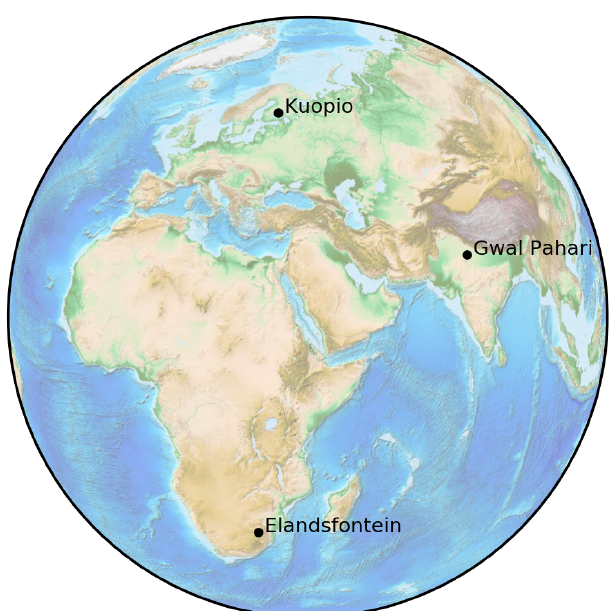
Figure 1. Map of the three measuring